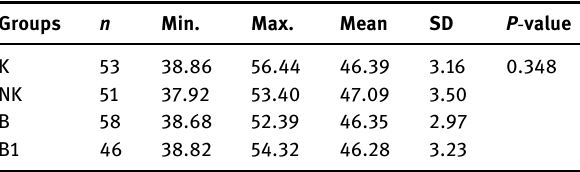
Table 2: Comparison of groups in terms of chick